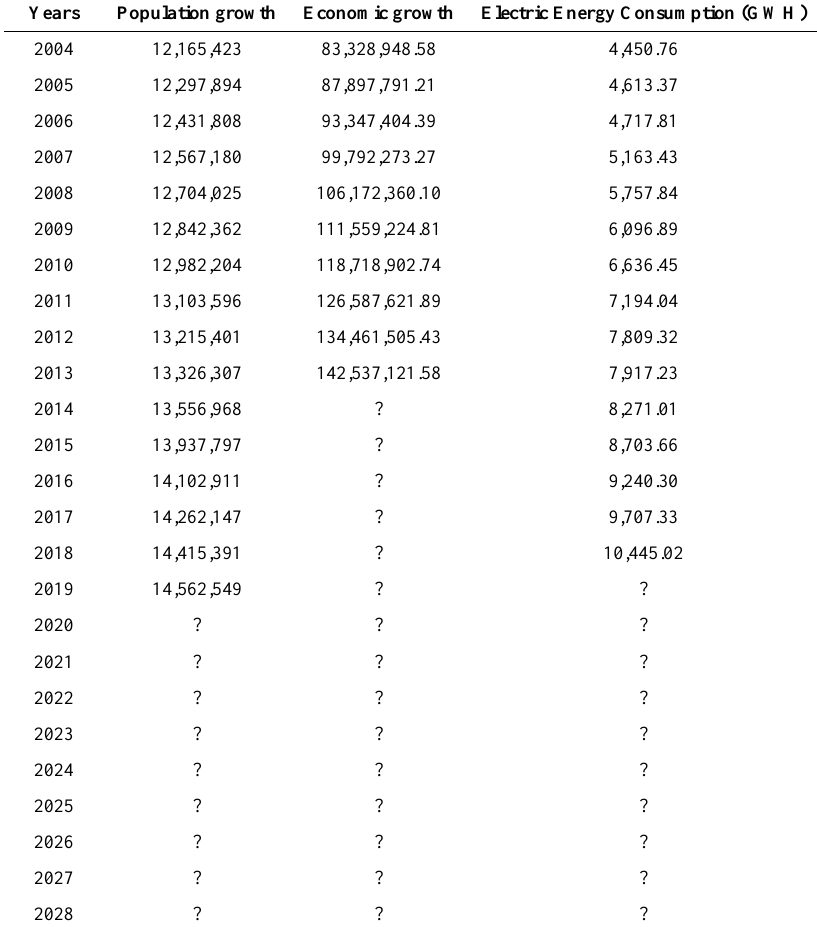
Table 1. Stages of